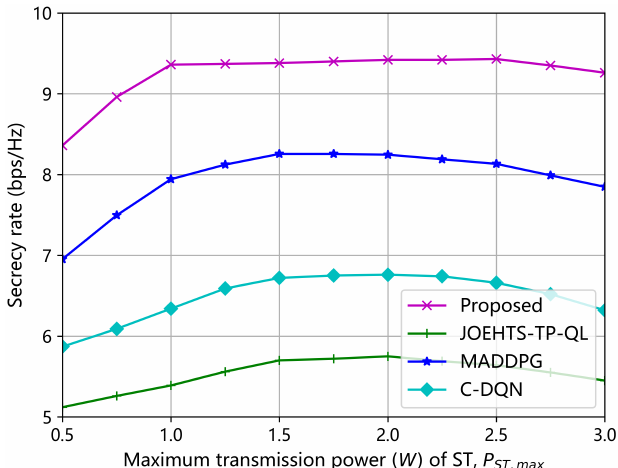
Figure 6. Secrecy rate versus maximum transmission power of